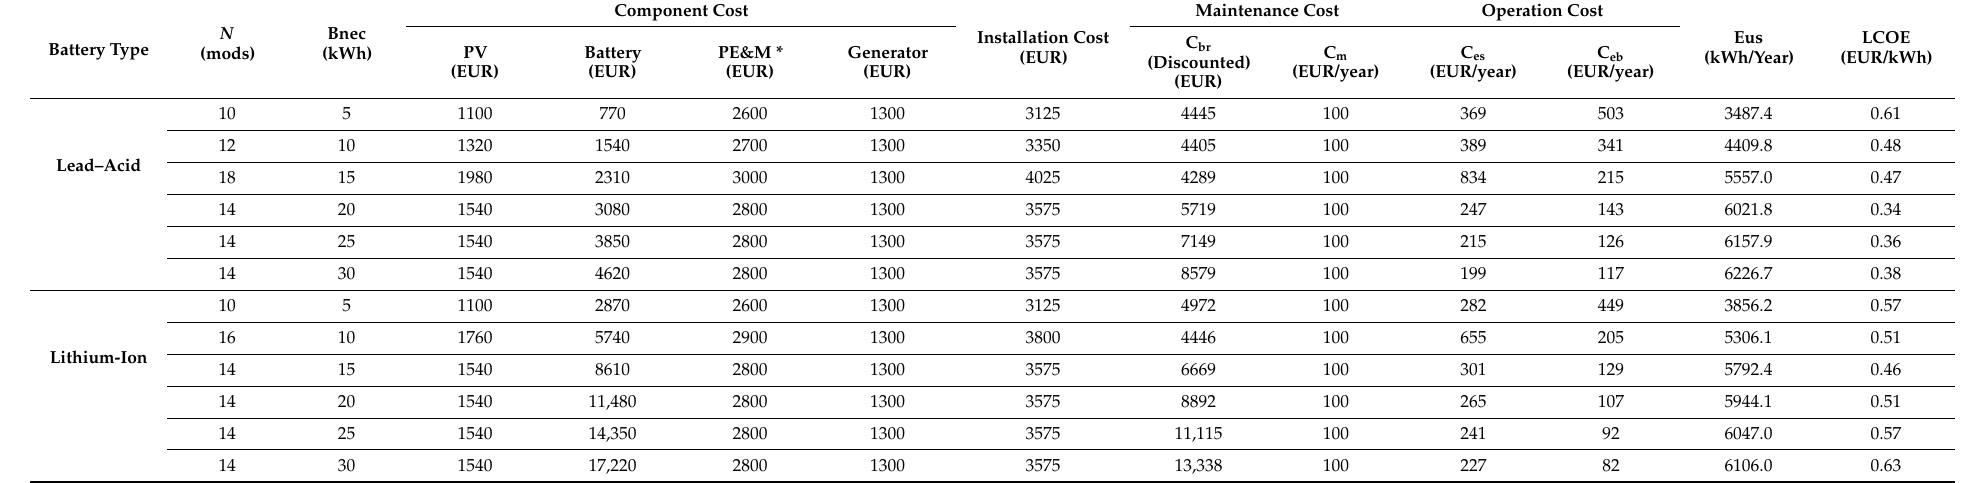
Table 2. The values of the parameters used to calculate the LCOE at the point where the minimum